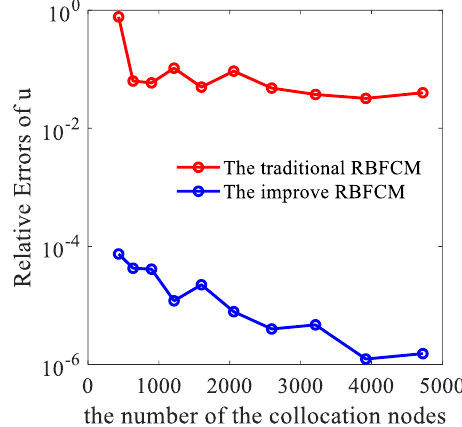
Figure 15. Relative errors with different numbers of collocation nodes when R = 5.